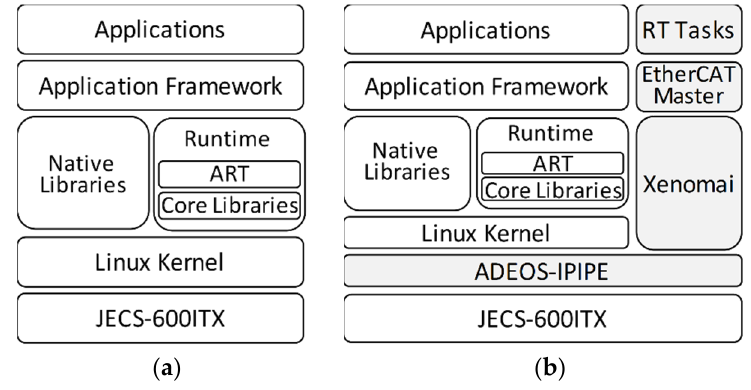
Figure 1. Simplified model of Android: ( a ) Standard Android; ( b ) Xenomai-integrated Android.